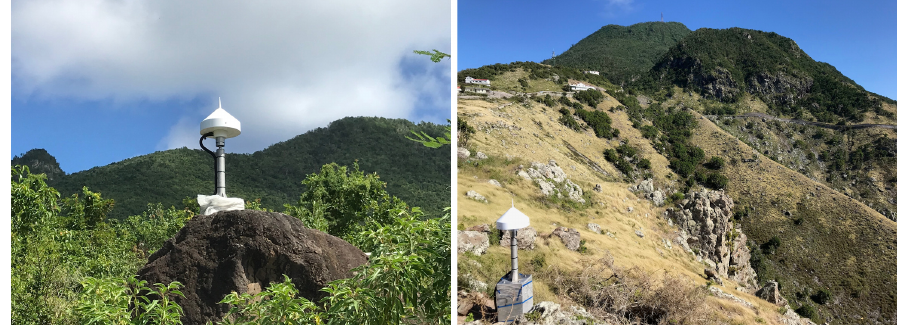
Figure 12. First continuous GNSS stations on St. Eustatius ( left ) with The Quill in the background and on Saba ( right ) in front of Mt. Scenery.